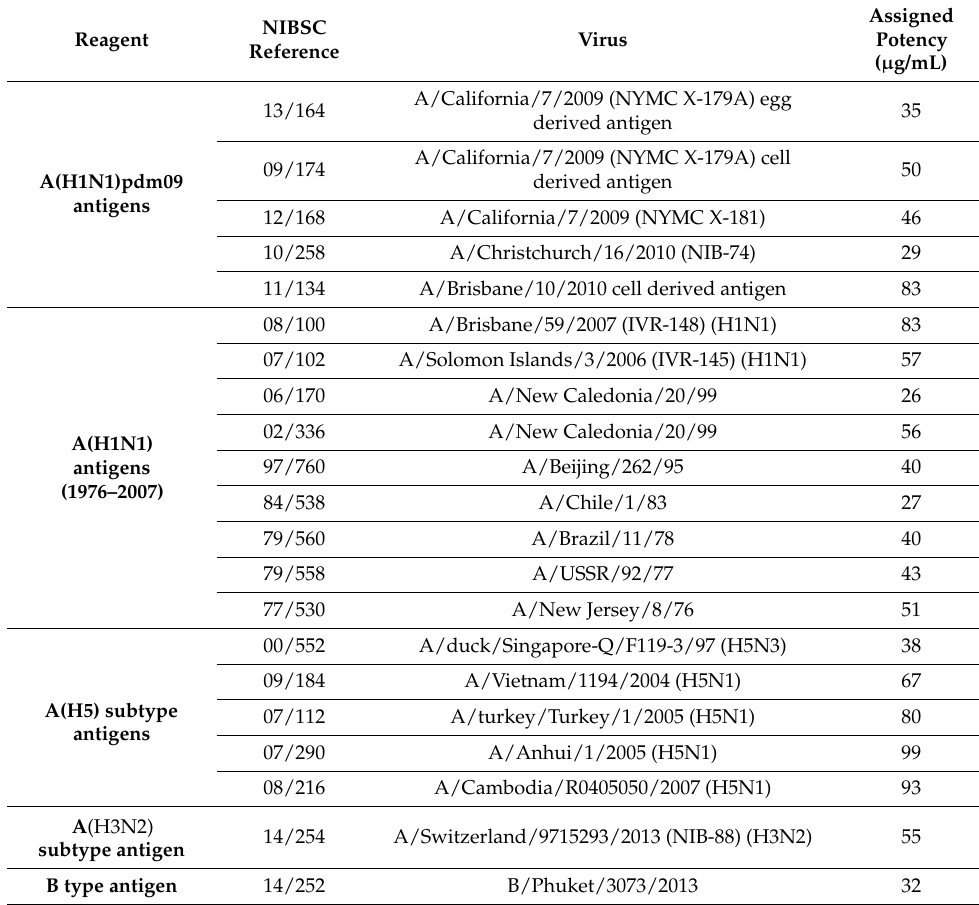
Table 1. Antigen reagents used in this